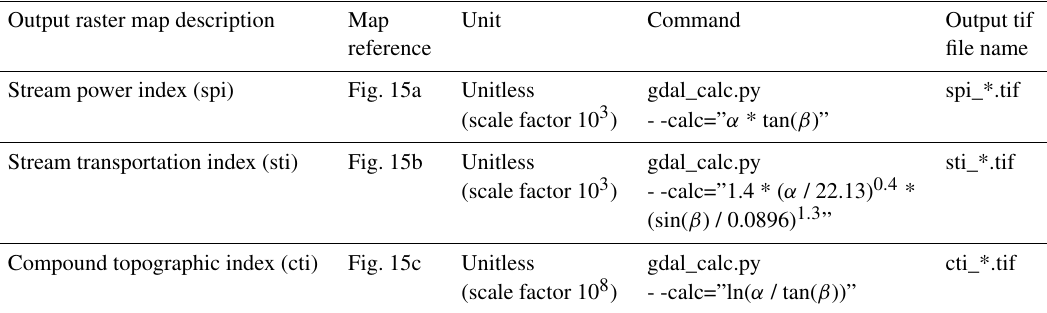
Figure 14. Maps (a) – (f) show different stream order types computed with the r.stream.order GRASS GIS module. All stream order layers are also available as vector data together with their attribute table. Map (g) shows the blue stream segments in vector format with the initialisation, node, and outlet vertices labelled as black points in Table 6. Table 7. The compound topographic index (cti), stream power index (spi), and stream transportation index (sti) derived from flow accumu- lation ( α ) and terrain slope ( β ); map reference corresponding to Fig. 15; unit; specific GDAL command; and output layer